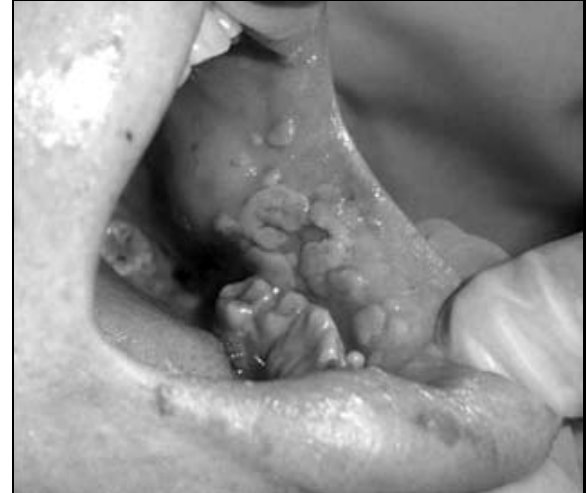
Figura 1 – Exame intra-oral evidenciando na mucosa jugal múltiplos nódulos de tamanho variado, alguns dos quais coalesciam